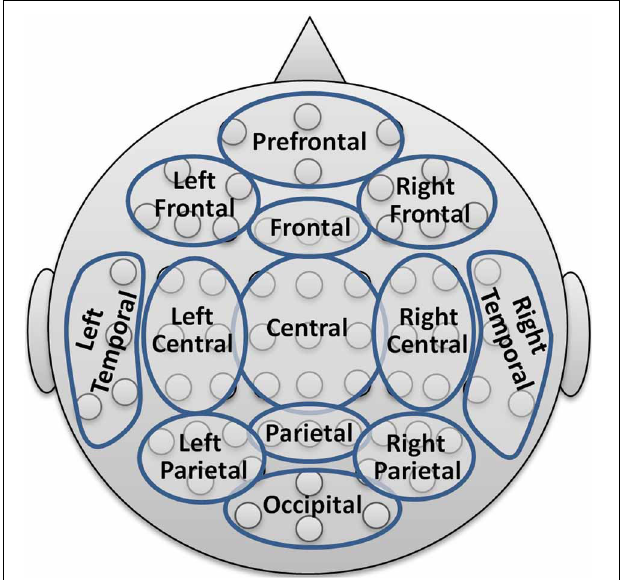
FIGURE 2 | Reduction scheme into 13 major topographic brain regions.